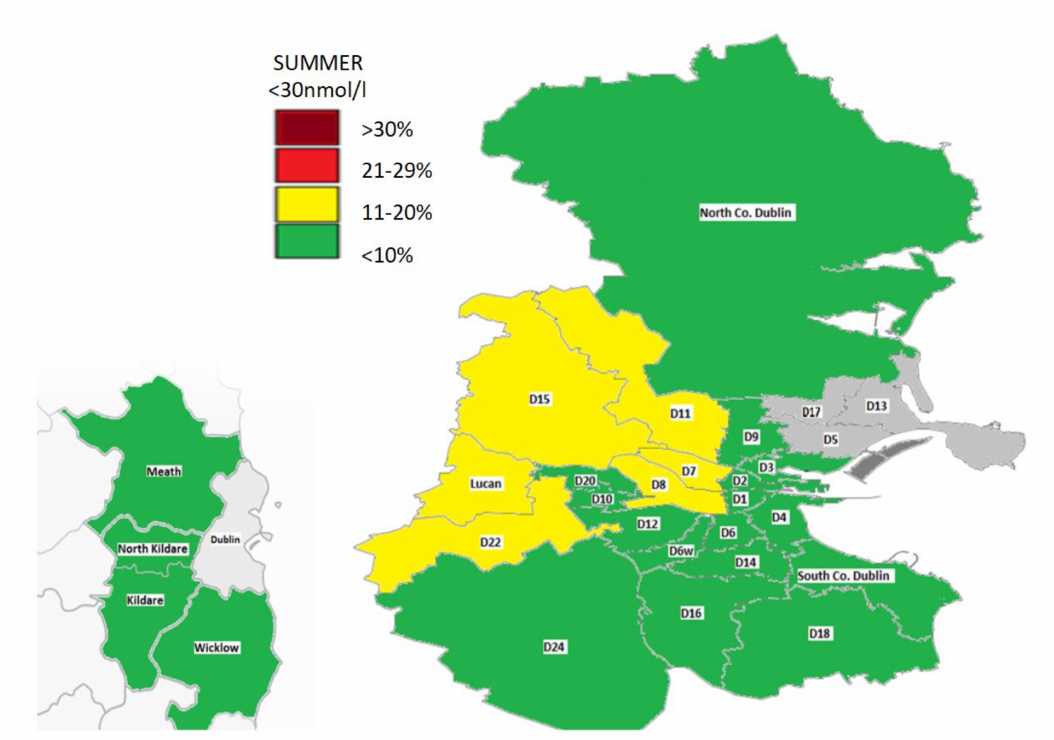
Figure 4. Geomap of 25(OH)D status in Dublin and surrounding counties in summer. Areas with insu ffi cient numbers ( < 120) for analysis are shown in